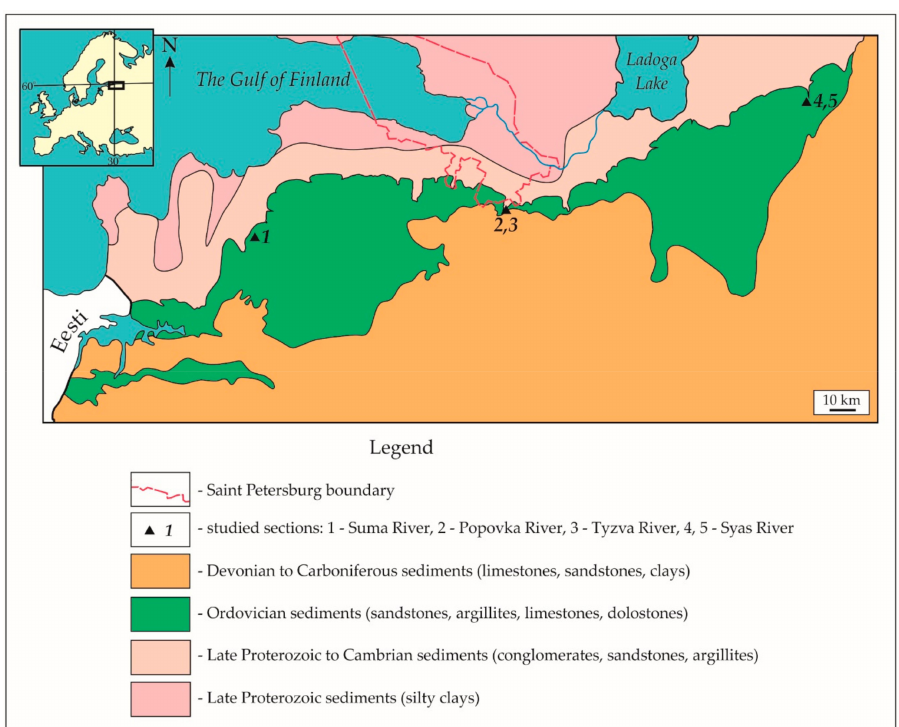
Figure 1. Location of studied sections in the Russian part of the Baltic-Ladoga Klint.